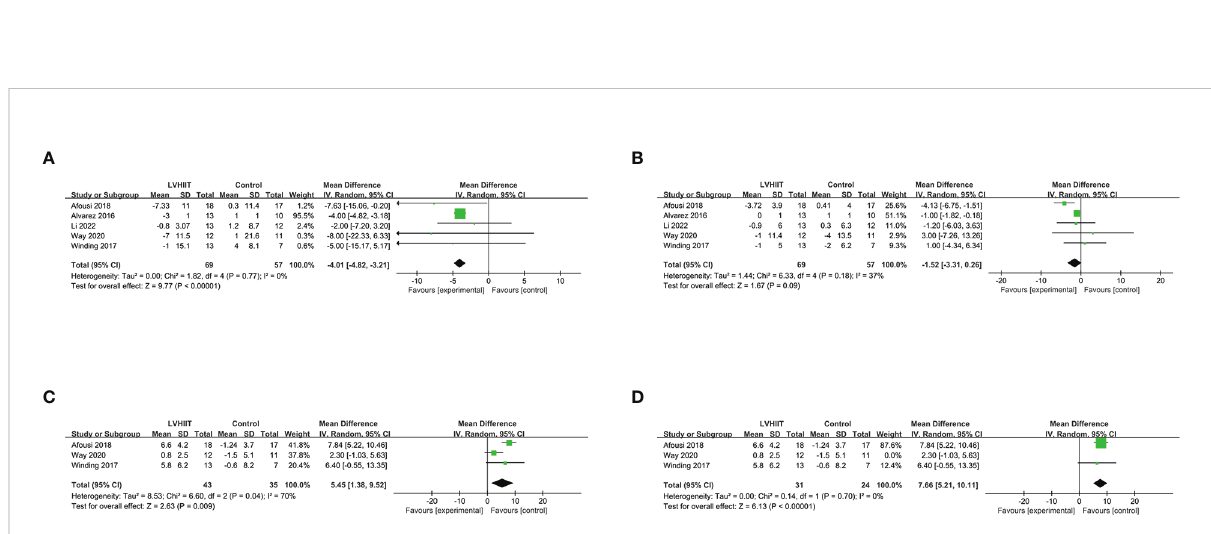
FIGURE 8 Forest plot for the meta-analysis of cardiorespiratory fi tness (A) systolic blood pressure and (B) diastolic blood pressure; (C) relative VO2 peak; (D) after sensitivity